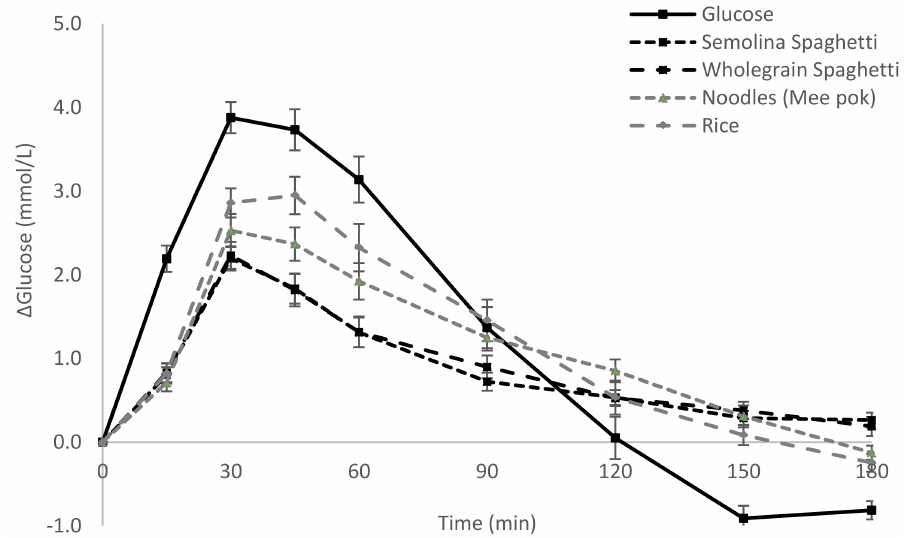
Figure 1. Postprandial change in glucose (mean ± standard error).